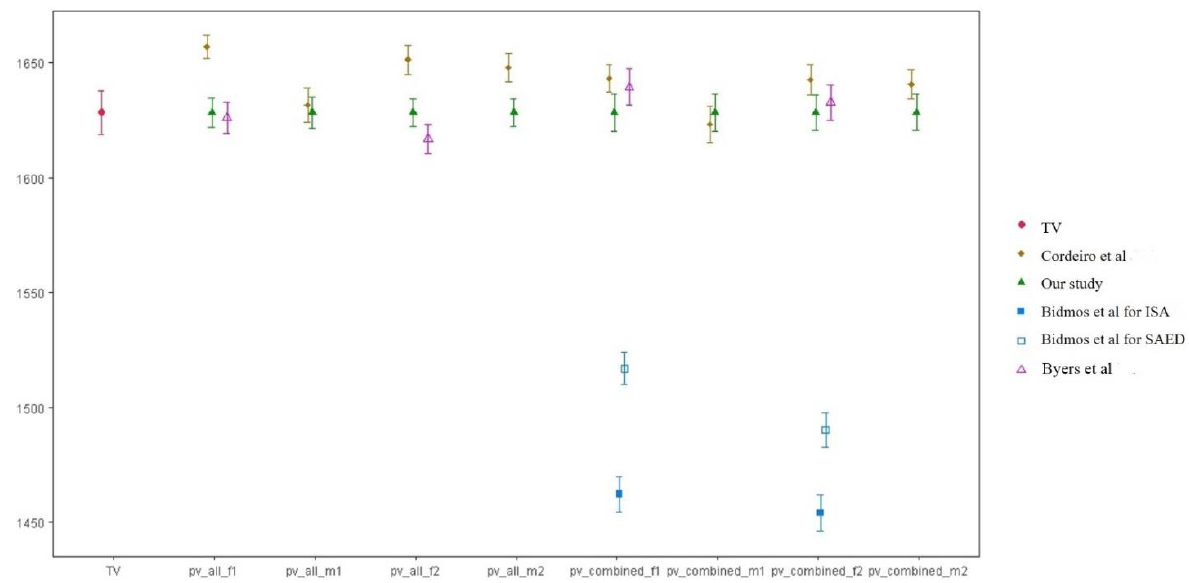
Figure 3. Comparison of true stature value (TV) with the predicted stature values (PV) by ours and formulas derived from other population affinities (Y-axis, stature (mm); X-axis, each stature value). TV, true stature value; PV, predicted stature value); F1, first metatarsal physiological length; F2, second metatarsal physiological length; M1, first metatarsal maximal length; M2, second metatarsal maximal length; all, unknown sex; combined, males and females combined; ISA, indigenous South